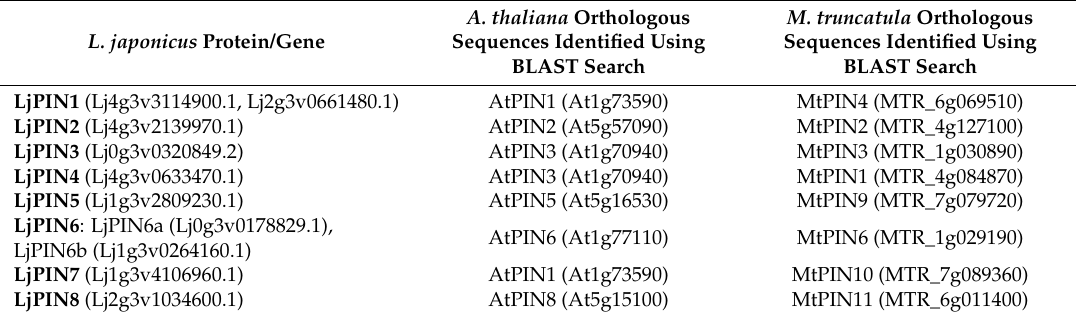
Table 1. L. japonicus PINs and their closest A. thaliana and M. truncatula orthologs, identified using BLAST